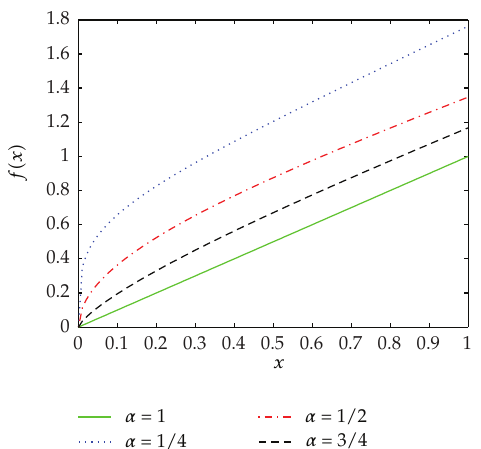
Figure 1: The approximate solution of Example 6.1 for N (cid:8) 1, M (cid:8) 2.